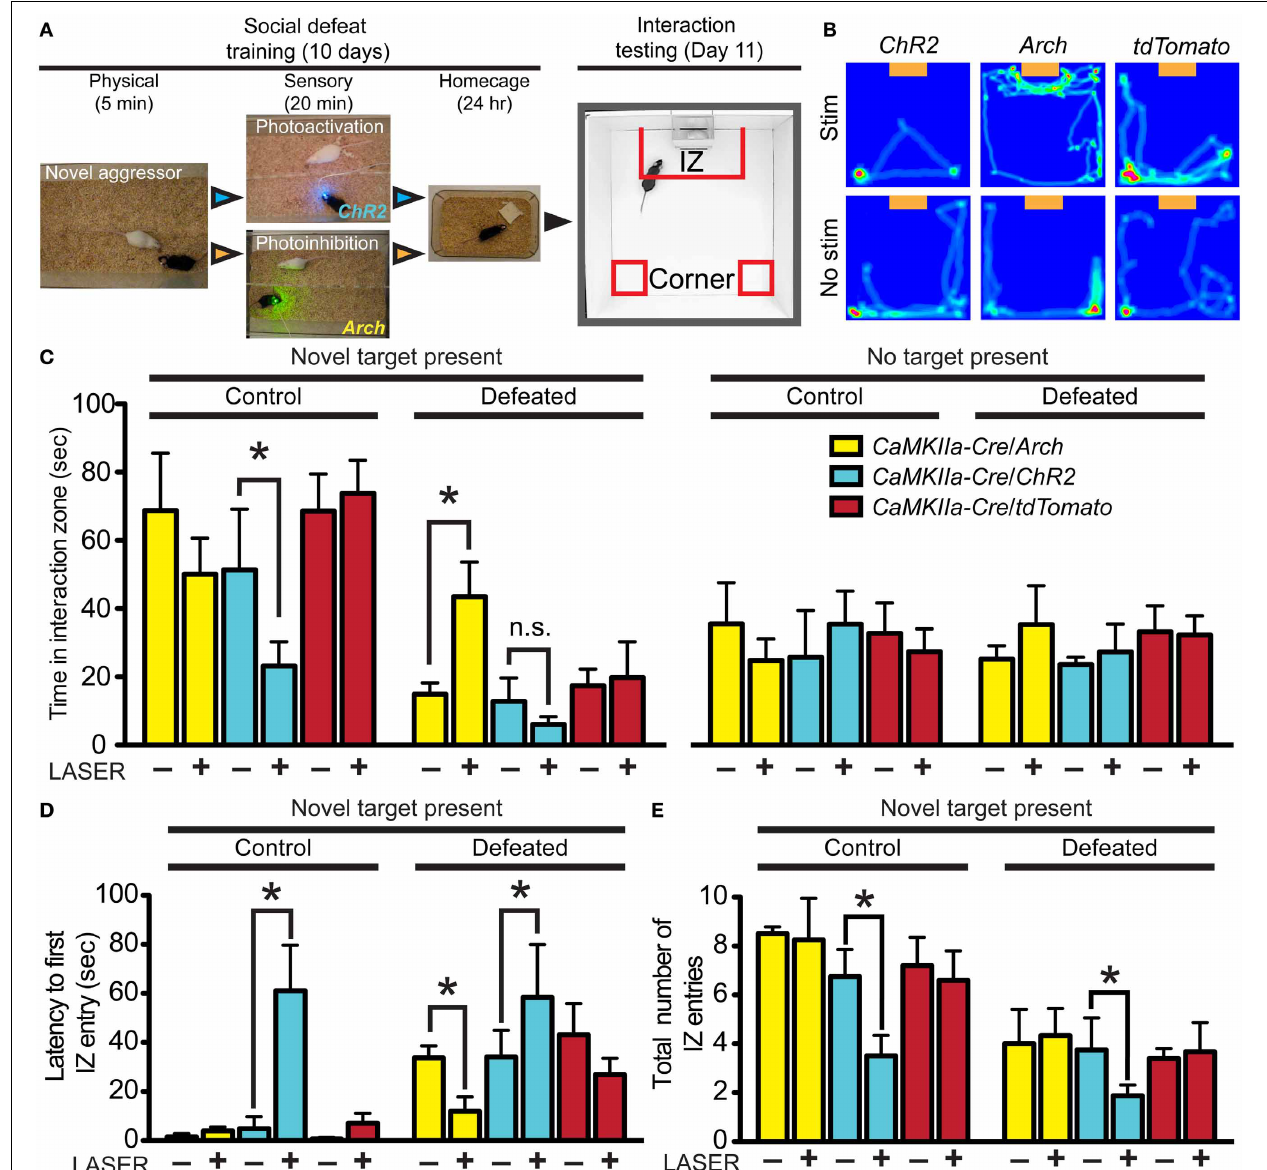
FIGURE 6 | Divergent effects of vmPFC terminal photostimulation and photoinhibition in the DRN. (A) CaMKIIa-Cre mice were injected in the vmPFC with Cre -dependent AAVs coding for the expression of ChR2-YFP , Arch-GFP or tdTomato . Cohorts of mice were exposed to 5min of physical defeat followed by 20min of sensory contact with either photoactivation by ChR2 (473nm, 10mW, 25Hz, 10ms pulse width) or photoinhibition by Arch (561nm, 10mW) of vmPFC terminals via implanted fiber optic targeting the DRN. Mice were then placed in homecages overnight. This was repeated with exposure to a novel aggressor each day. On day 11, mice were assessed for approach or avoidance in the social interaction test. IZ —interaction zone. (B) Heat maps depicting representative behavioral effects of photoactivating (C hR2 ) or photoinhibiting ( Arch ) vmPFC terminals during the sensory period of social defeat on interaction with a novel social target (orange box). Red and green areas depict areas where mice spent the most time. No effect was observed in mice injected with sham tdTomato virus. (C) In defeated mice, photosilencing of vmPFC terminals prevented a decrease in social interaction